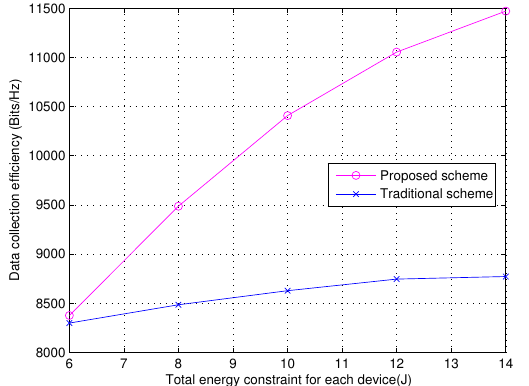
Figure 6. Comparison of data collection efficiency versus total energy constraint of each device for the incremental beam selection scheme and the MCMS beam selection scheme, both with the aid of the proposed trajectory planning scheme and iterative algorithm.